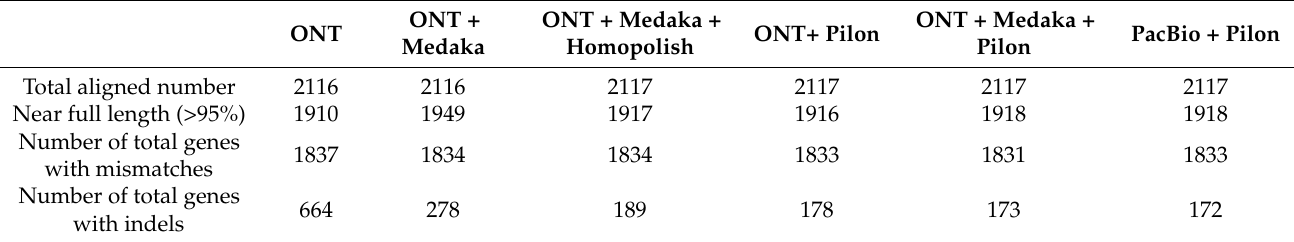
Table 5. Results of BLAT alignment between transcripts and assembled genomes.